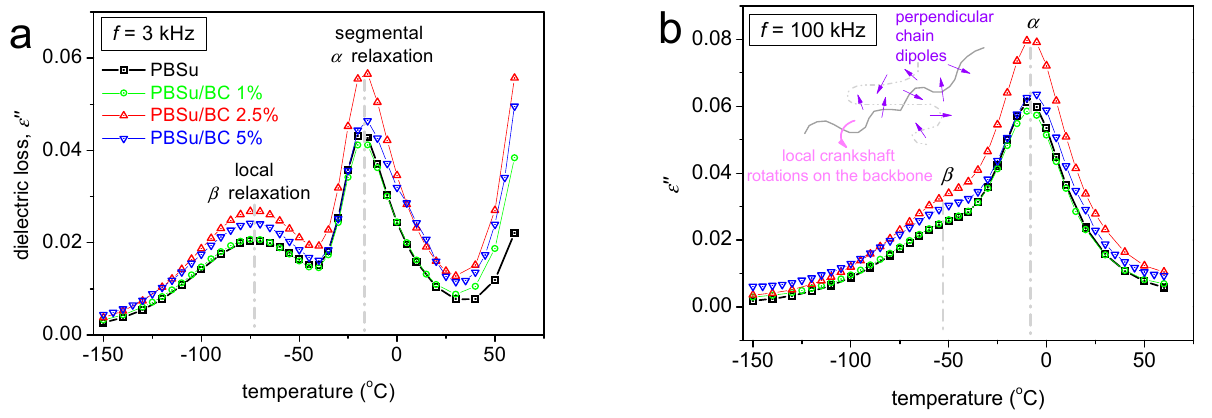
Figure 10. Comparative isochronal BDS curves, namely, the temperature dependence of the imagi- part of dielectric permittivity, ε ”, for PBSu and the PBSu/BC biocomposites, for ( a ) f = 3 kHz and nary part of dielectric permittivity, ε ″ , for PBSu and the PBSu/BC biocomposites, for ( a ) f = 3kHz ( b ) f = 100 kHz. Indicated are the local and dielectric relaxation and ( b ) f =100 kHz. Indicated are the local and dielectric relaxation processes.